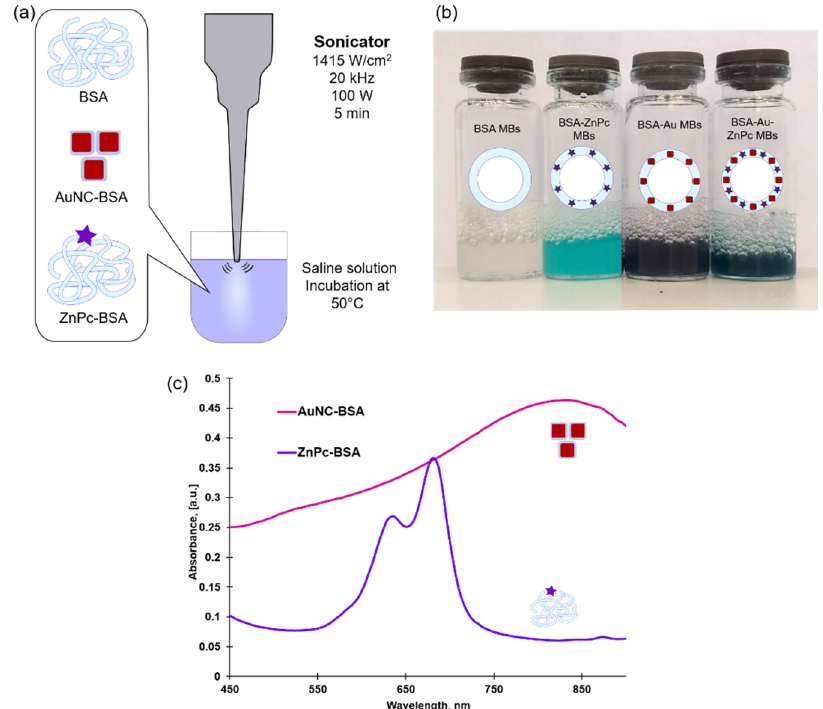
Figure 2. ( a ) Sonication method of microbubbles preparation. Bovine serum albumin (BSA) is used as the main component of microbubbles’ shells. BSA-coated gold nanocages (AuNC-BSA) and BSA- conjugated photodynamic dye zinc phthalocyanine (ZnPc-BSA) were used as functional additives. Dissolved in saline, solutions were incubated at 50 °C and sonicated for 5 min. ( b ) Photographs of resulting microbubbles solutions of different content: with BSA shell (BSA MBs), stabilized with ZnPc (BSA-ZnPC MBs), stabilized with Au NCs (BSA-Au MBs), and with both additives at the same time (BSA-Au-ZnPc MBs); ( c ) absorption spectra of BSA-coated gold nanocages (AuNC-BSA) and BSA-conjugated zinc phthalocyanine (ZnPc-BSA).